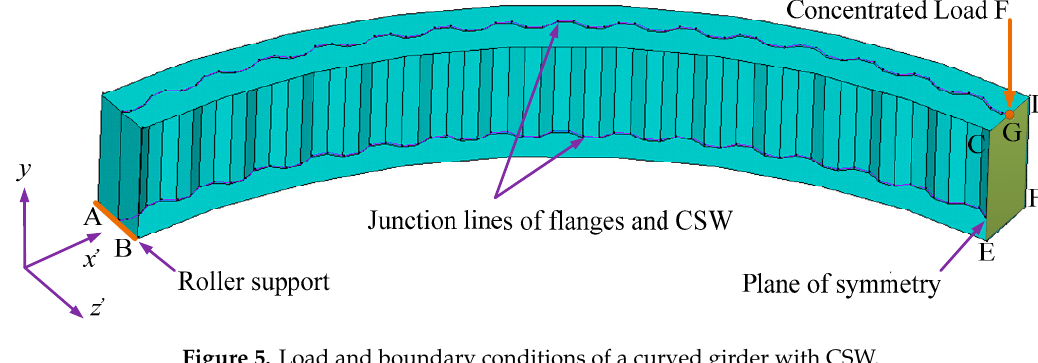
Figure 5. Load and boundary conditions of a curved girder with CSW. Table 8. Boundary conditions of finite element models.